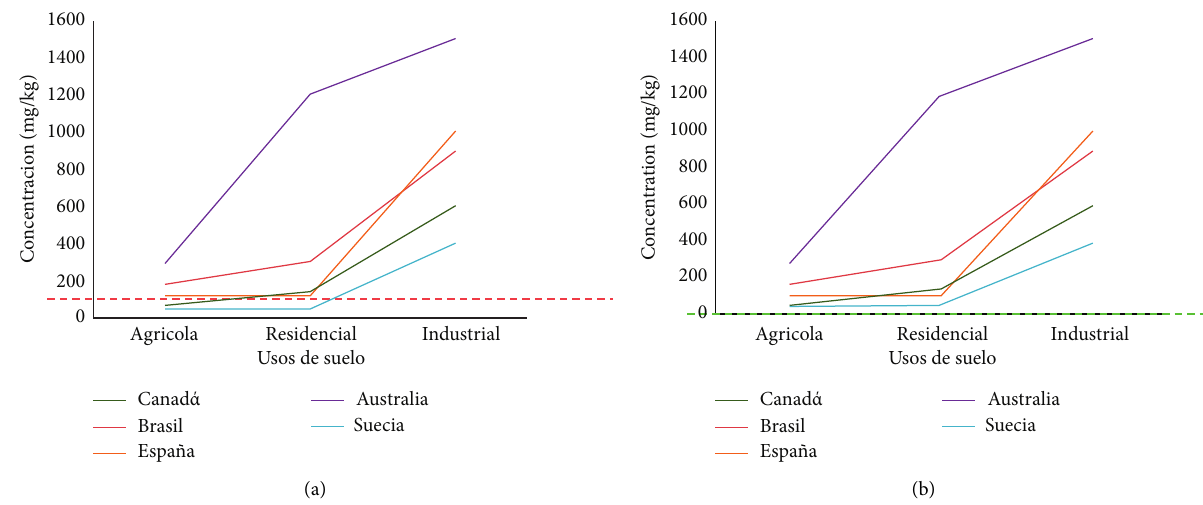
Figure 9: (a) Comparison of average Pb concentration with international regulations prior to phytoremediation. Own elaboration from [50] National Environment Center (2012). (b) Comparison of the average concentration of Pb with the international regulations after